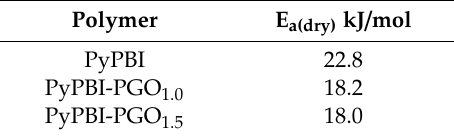
Table 6. Activation energies for the PyPBI-phosphonated graphene oxide (PGO) composite membranes doped